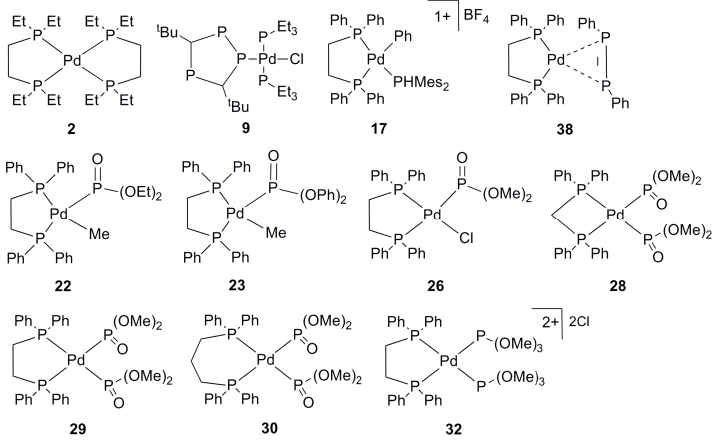
Figure 2. “Training” set of palladium complexes. Table 1. R 2 dependence on combination used in the calculations for the “training” set of Pd com- plexes ( 2 , 9 , 17 , 22 – 23 , 26 , 28 – 30 , 32 , 38 ).